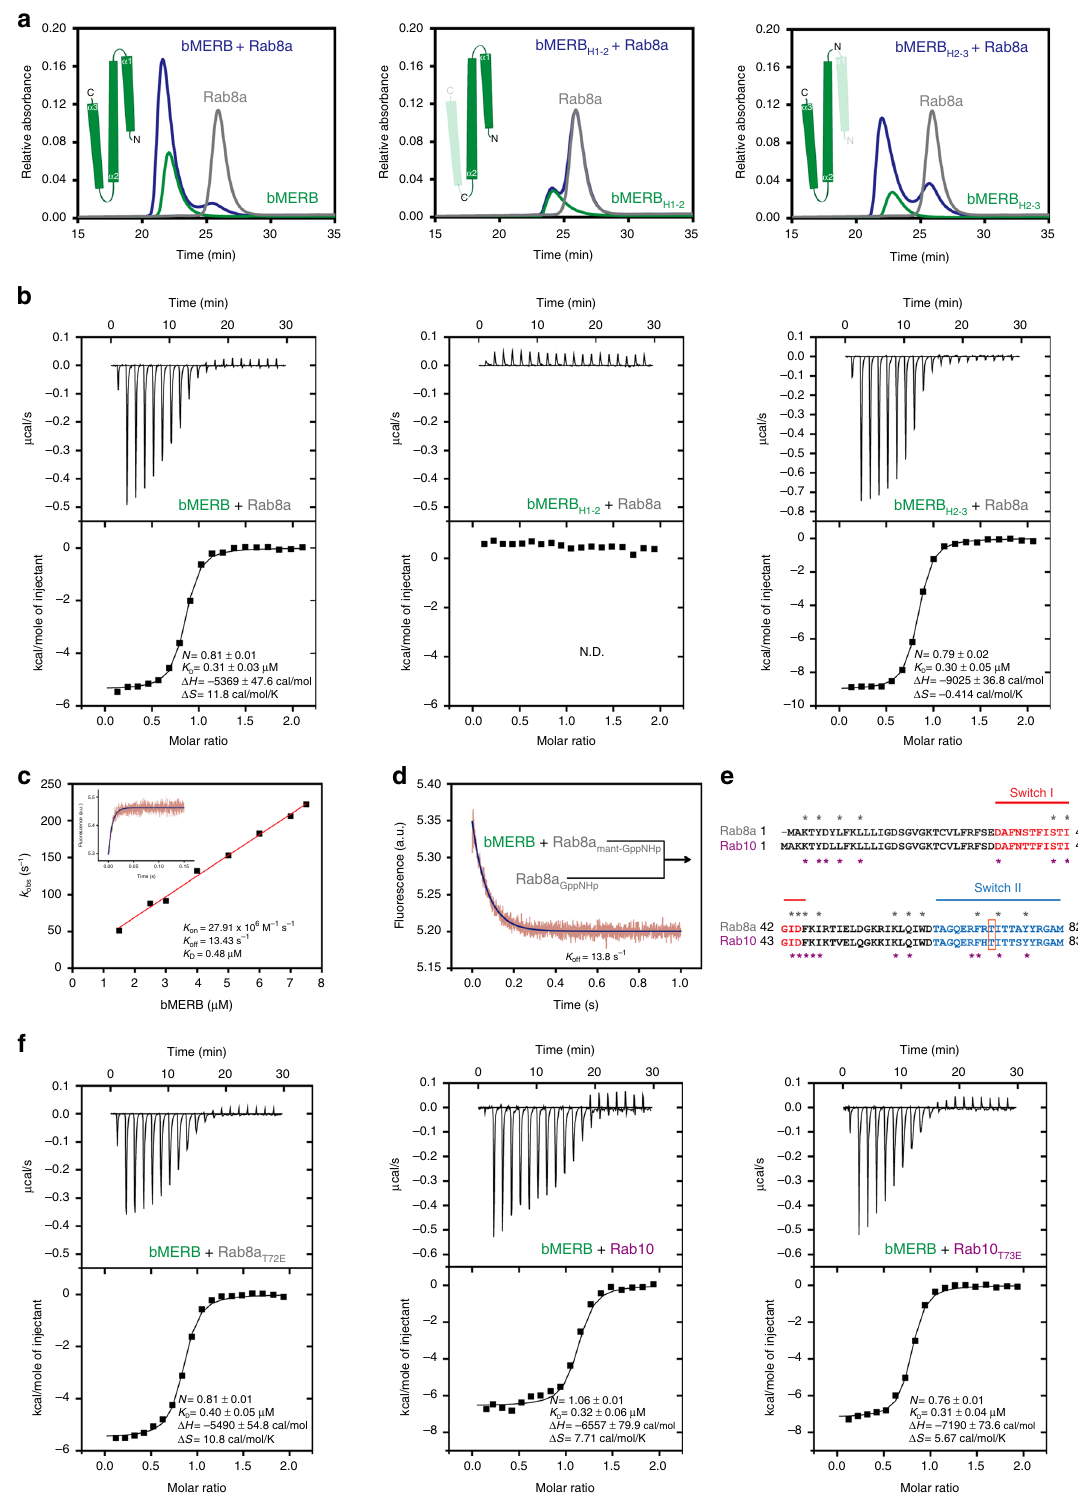
Key elements of the CH:bMERB interface . To identify the crucial key residues required for complex formation, we puri fi ed a series of CH as well as bMERB domain mutants and checked their interaction using ITC measurements. Beginning with the C- terminal interacting residues of the CH domain, we could show that mutation of the conserved D532 to alanine leads to a